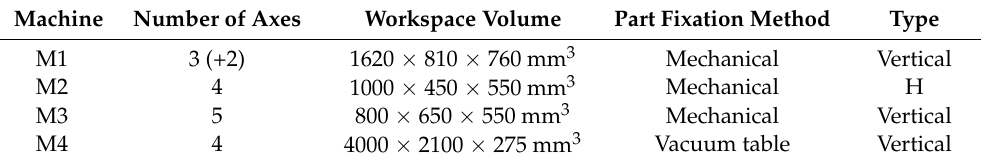
Table 1. Considered CNC milling machining centers.